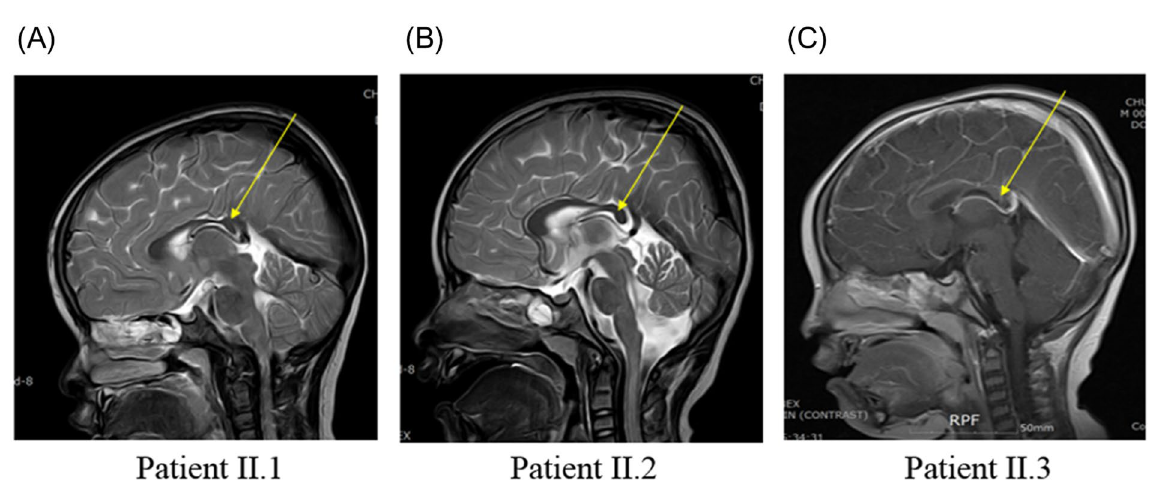
Figure 2. Axial T2-weighted magnetic resonance image of patients. ( A , Patient II.1; B , Patient II.2; C , Patient II.3) MRI shows thinning of corpus callosum on axial T2- weighted image which is shown in yellow